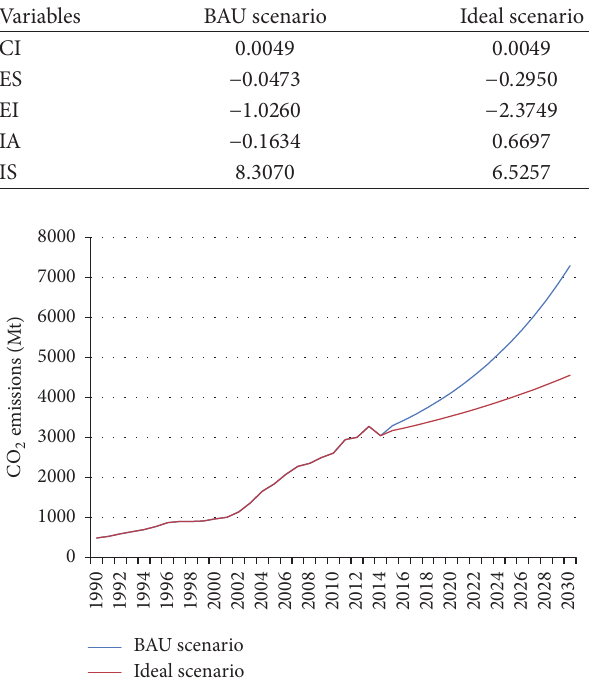
Figure 9: CO 2 emissions in China’s power sector under BAU scenario and ideal scenario.